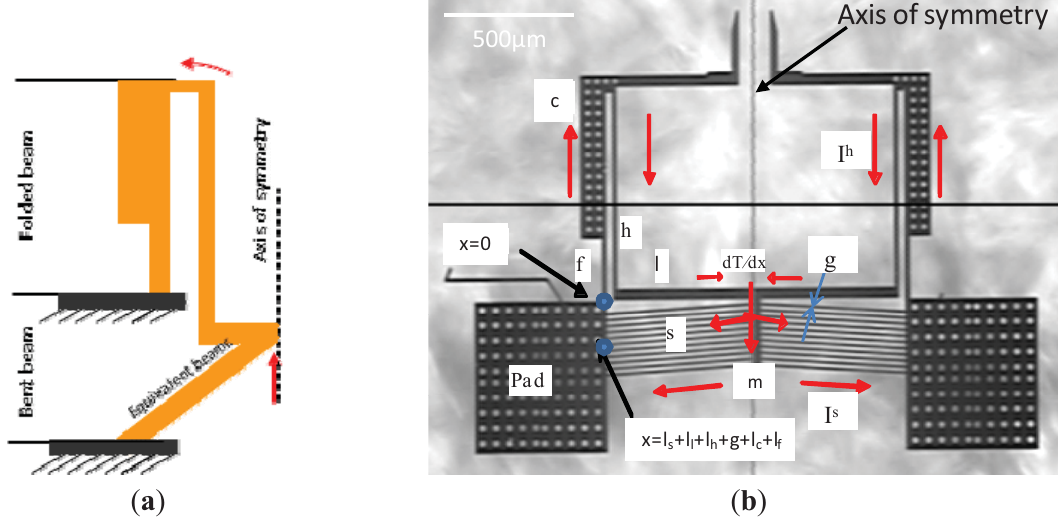
Figure 3. Micro grasper combining folded and bent beam mechanisms: ( a ) sketch; ( b ) E-T actuator fabricated from